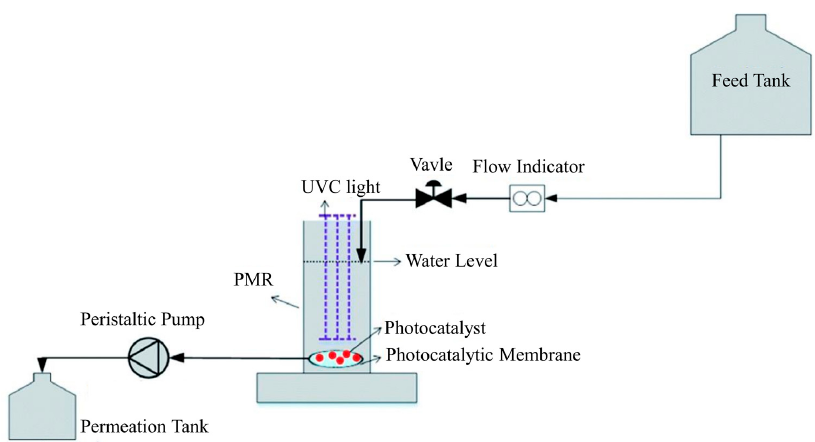
Figure 2. Schematic diagram of a dead-end PMR for bilge water degradation and separation. Adapted with permission from [36], Copyright Royal Society of Chemistry, 2015. Catalysts 2017 , 7 , 224